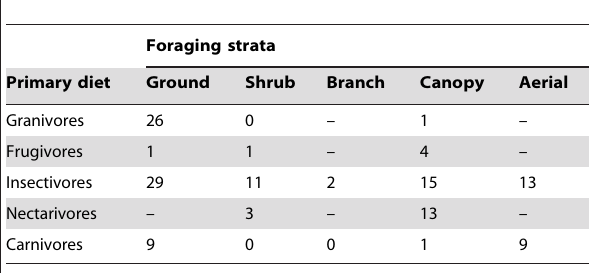
Table 1. The number of species within each of the 15 functional groups defined by both diet and foraging strata, used in the analysis of functional